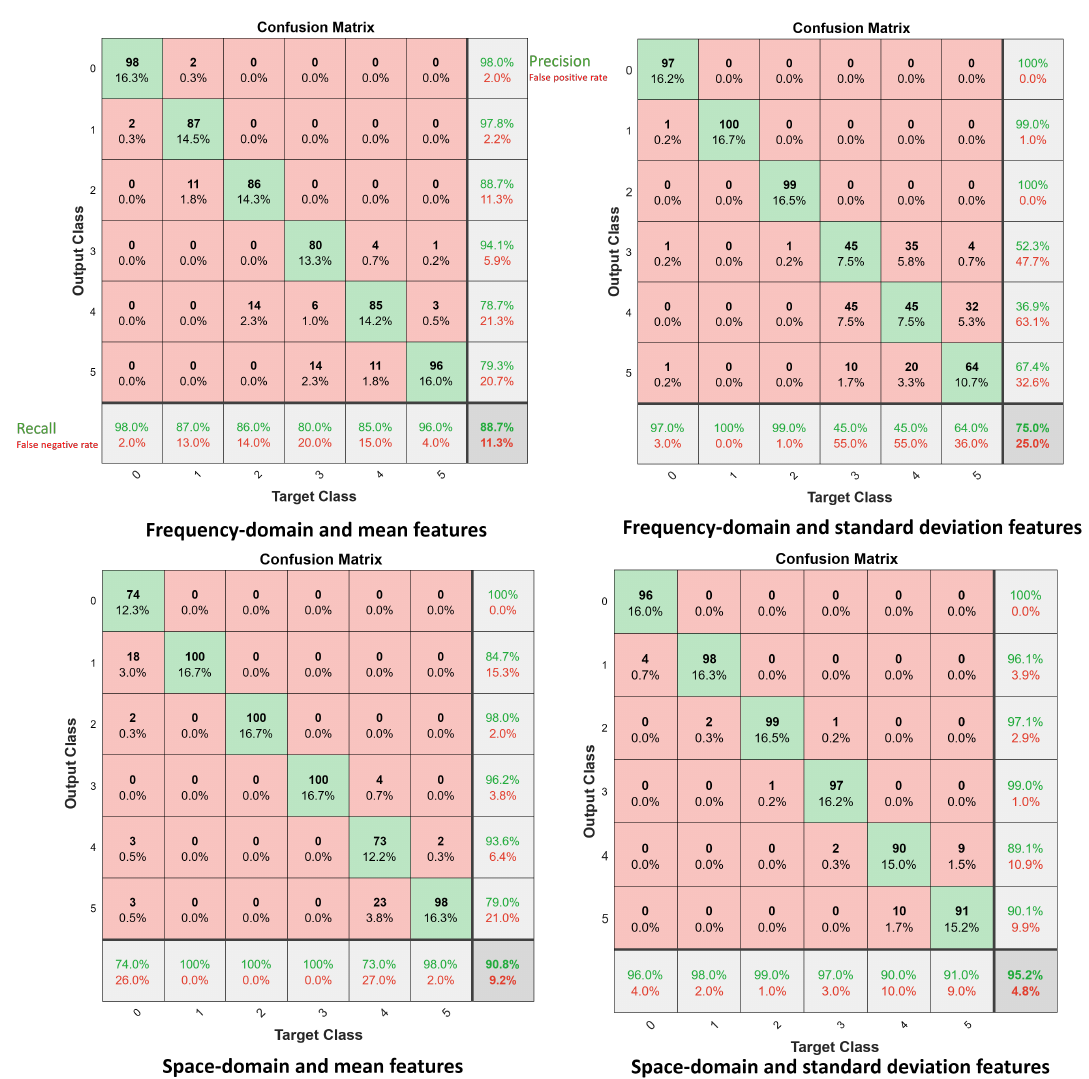
Figure 10. Confusion matrices for the LSTM classifier for subject counting, C = 0,1,2,...,5. Top figures: frequency domain CSI features: mean ( left ) and standard deviation ( right ). Bottom figures: space domain CSI features: mean ( left ) and standard deviation (right